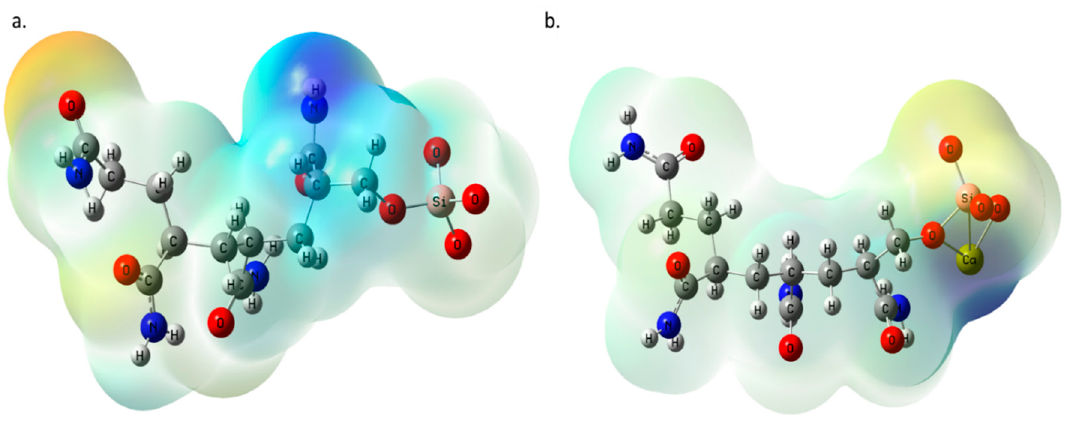
Figure 4. The molecular electrostatic potential maps for ( a ) PAM ‐ Silica and ( b ) Ca ‐ PAM_Silica2. The Highest Occupied Molecular Orbital (HOMO) and Lowest Unoccupied Molecu ‐